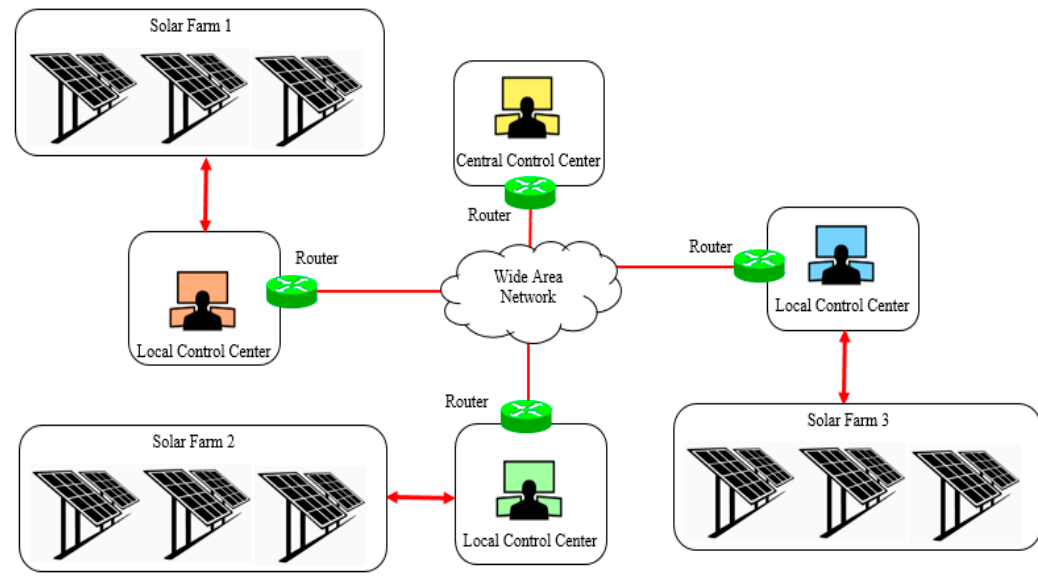
Figure 2. Communication network for a PV monitoring system.